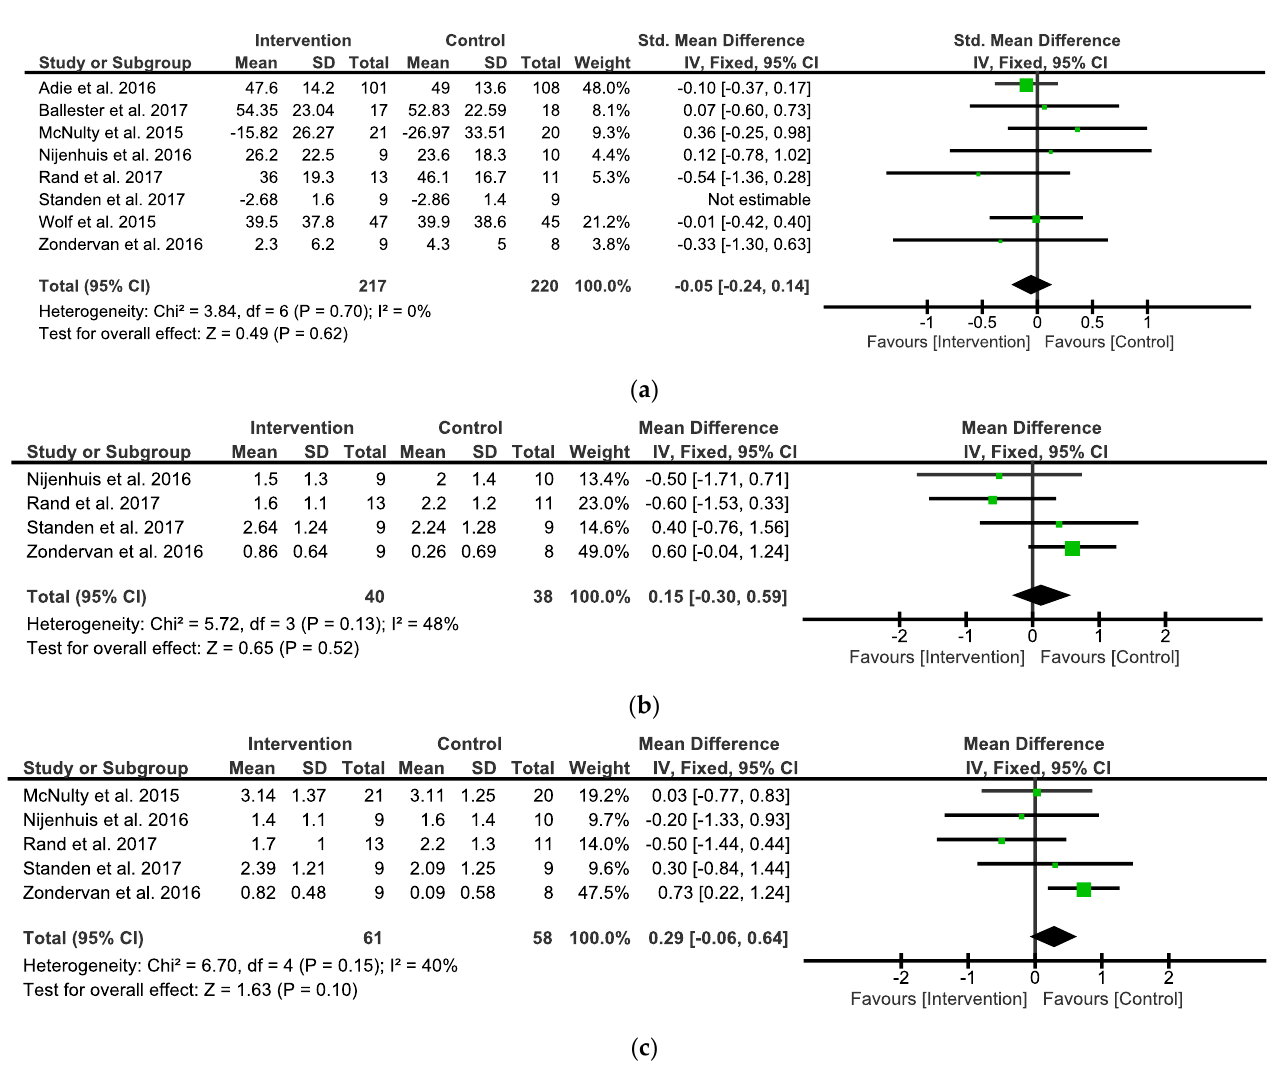
Figure 2. Forest plots between Intervention and Control Groups in post intervention. ( a ) SMD for the observed outcome; ( b ) MD for the self-reported outcomes MALAOU; ( c ) MD for the self-reported outcomes MALQOM. A pooled result favoring Intervention Group indicates negative values, and favoring Control group indicates positive differences between Intervention and Control Groups. Note: SMD = Standardized Mean Differences; MD = Mean Difference; MALAOU = Motor Activity Log Amount of Use; MALQOM = Motor Activity Log Quality Of Movement.